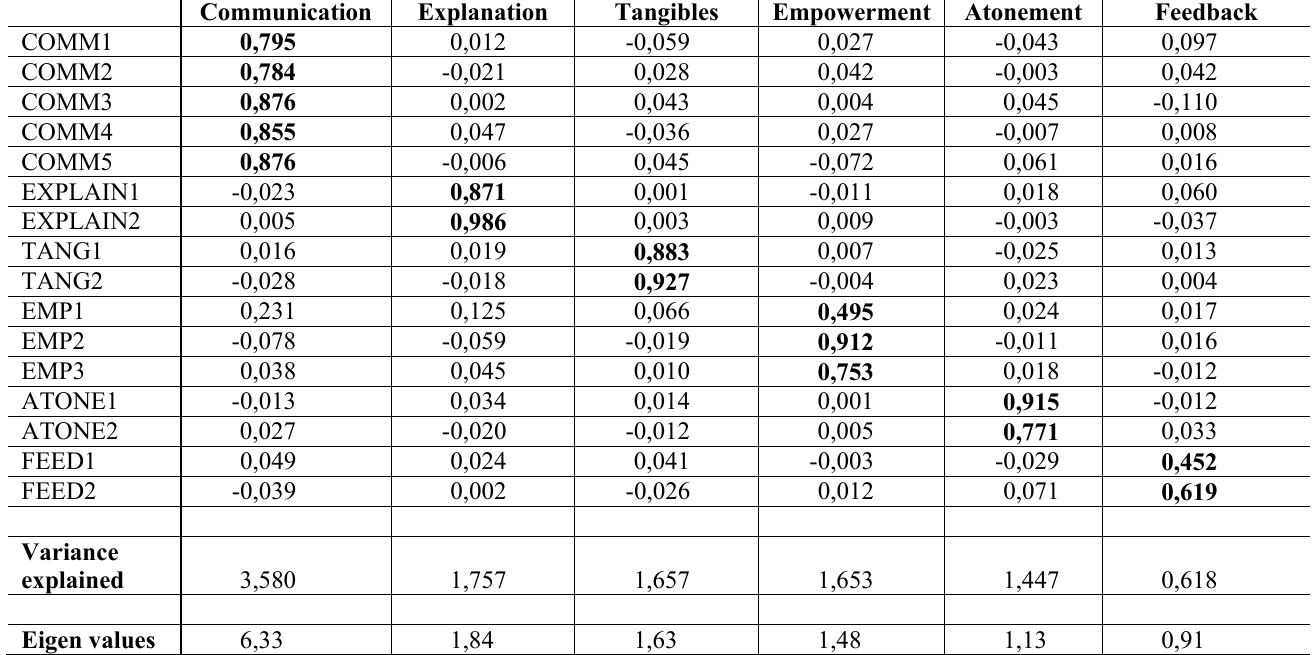
Table 3: The rotated factor loadings (1)